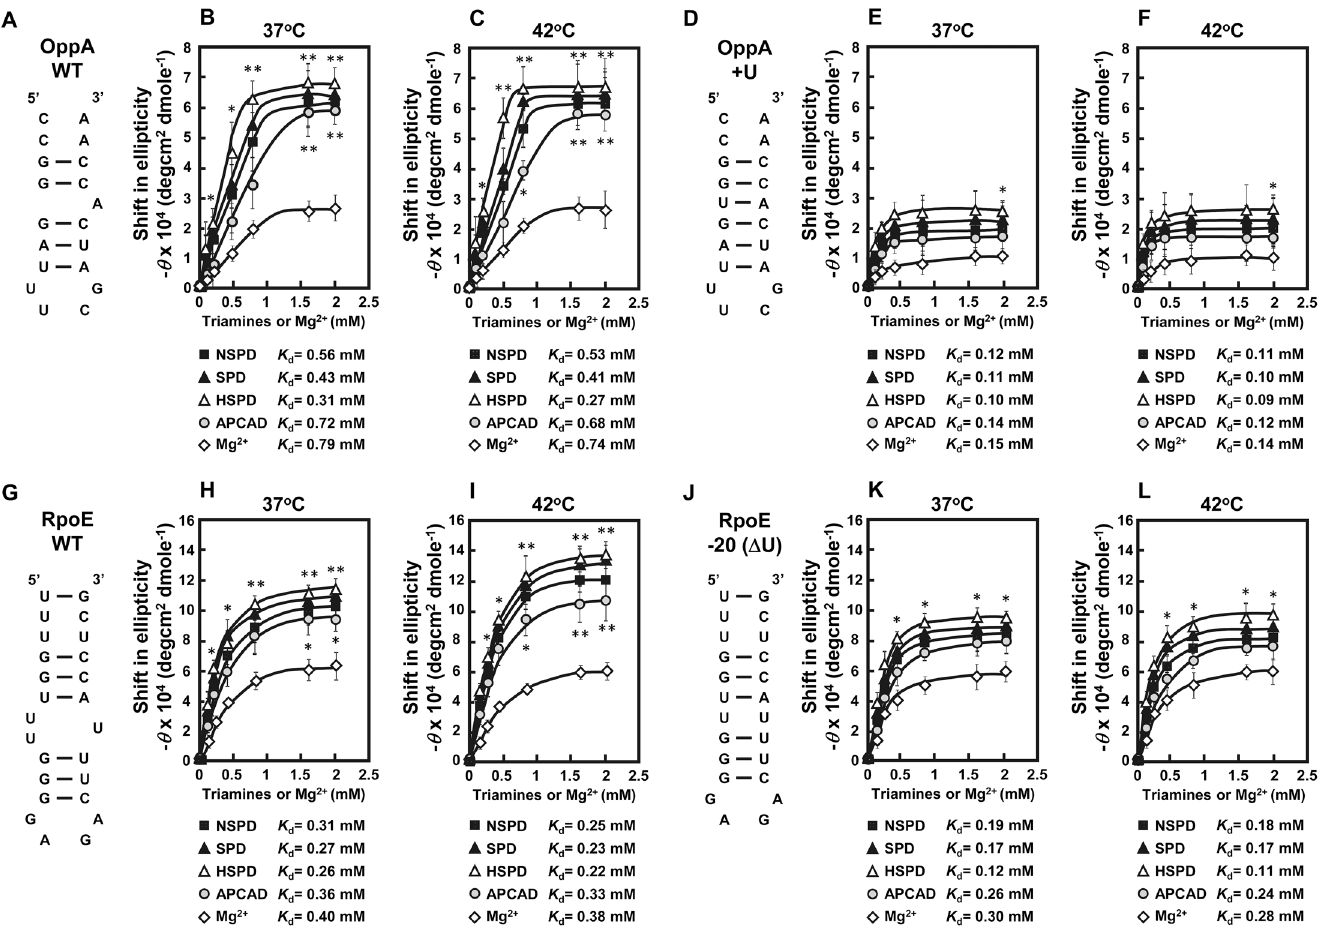
Fig 6. Stabilization of OppA and RpoE WT RNAs, and more stable modified RNAs measured by CD. A, D, G and J. Structures of OppA WT RNA, OppA + U RNA, RpoE WT RNA, and RpoE -20( Δ U) RNA are shown. B and C (OppA WT RNA), E and F (OppA + U RNA), H and I (RpoE WT RNA), and K and L (RpoE -20( Δ U) RNA). Concentration-dependent shifts induced by Mg 2+ or a triamine with 1 mM Mg 2+ at 37°C and 42°C in elliplicity at 208 nm are shown. Values are mean ± S. E. of triplicate determinations. The K d values of Mg 2+ and a triamine with 1 mM Mg 2+ were determined by the double reciprocal equation